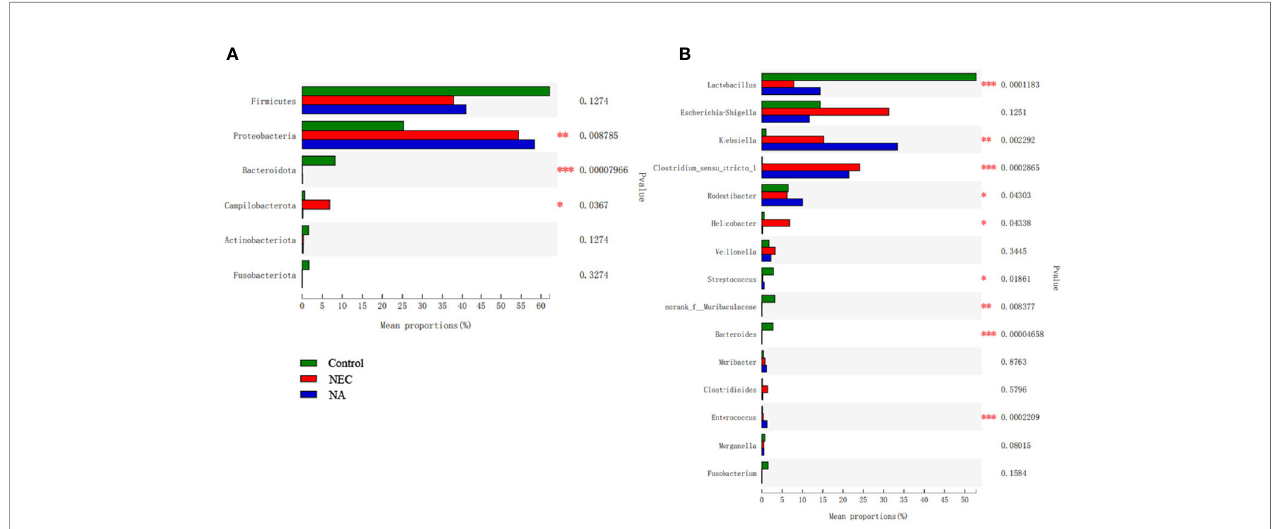
FIGURE 4 | (A) The fl ora composition of mice in the three groups at the phylum level. (B) The fl ora composition of mice in the three groups at the genus level. Numbers of samples: Con (n=12), NEC (n=10), and NA (n=11). Statistics: Kruskal-Wallis test with Scheffe ’ s post-hoc test. * 0.01 < P ≤ 0.05, ** 0.001 < P ≤ 0.01, *** P ≤ 0.001.